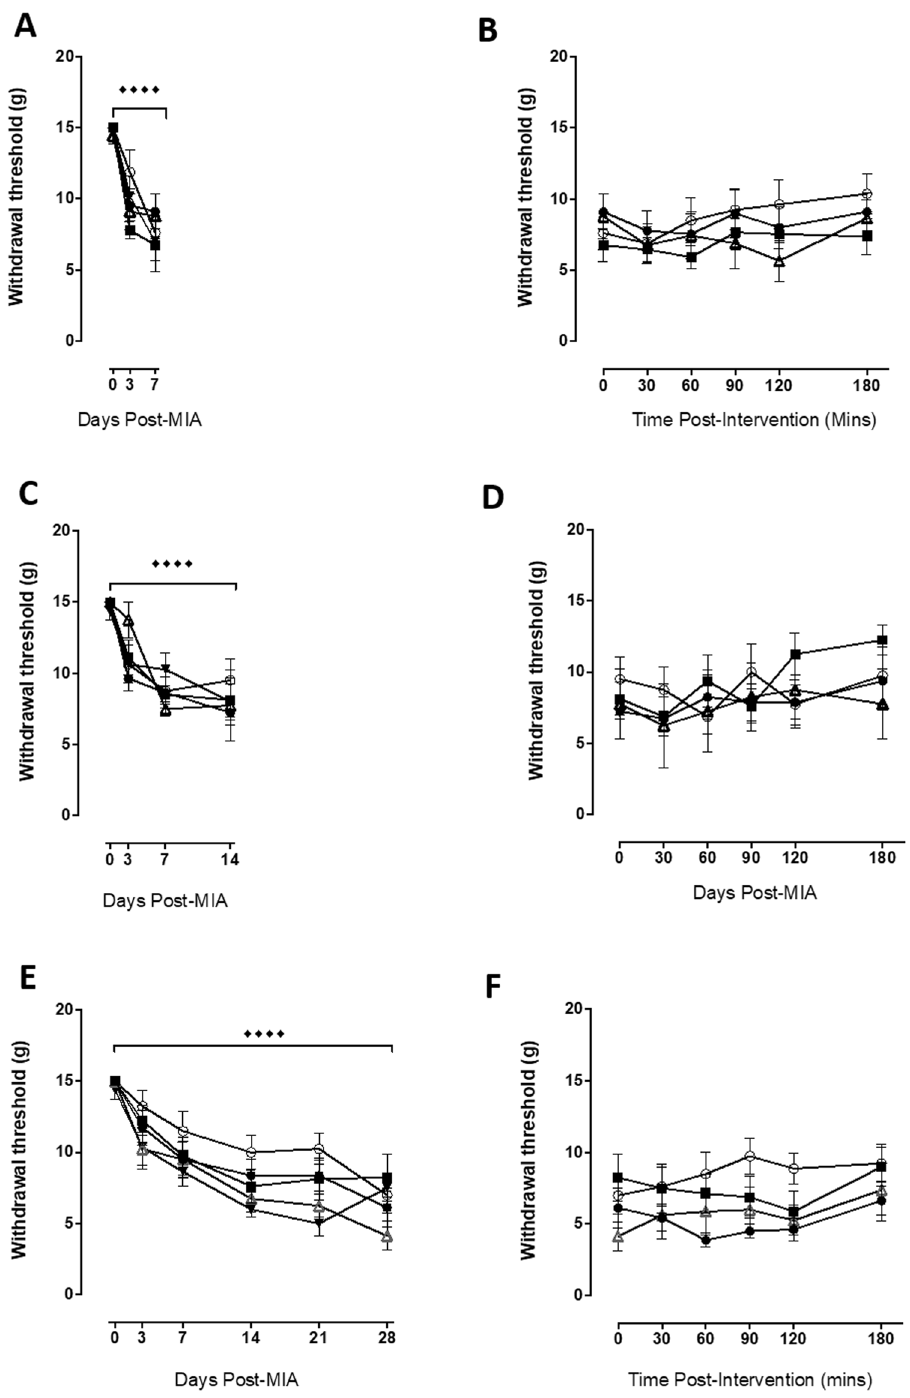
Figure 3. QX-314 + capsaicin is unable to effect MIA induced distal allodynia. Intra-articular injection of MIA significantly lowered PWTs 7 ( A ), 14 ( C ) and 28 ( E ) days following administration (Dunnett’s; ◆◆◆◆ p < 0.0001). Subsequent pharmacological treatments (intra-articular injection) were without effect at any of the post- MIA timepoints. ● = QX-314, ■ = QX314, Δ + capsaicin, = capsaicin, ○ = vehicle All data are presented as mean ±